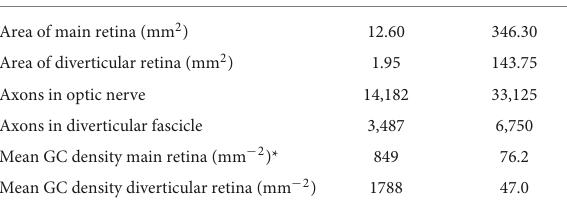
TABLE 2 Quantitative analysis of the retinae within the diverticulum and main eye of Dolichopteryx longipes (SL 102 mm) and Rhynchohyalus natalensis (SL 183